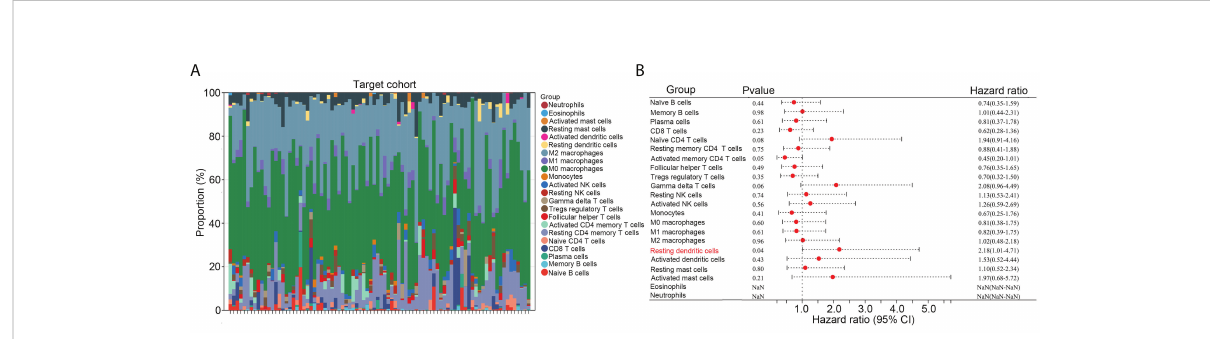
FIGURE 1 High in fi ltration of resting dendritic cells was related to poorer prognoses in OS. (A) The gene expression matrix of osteosarcoma tissues in TARGET was transformed into expression levels of 22 immune cells, through CIBERSORT. (B) The effects of the 22 immune cells on the survival rate of OS were analyzed via Kaplan survival